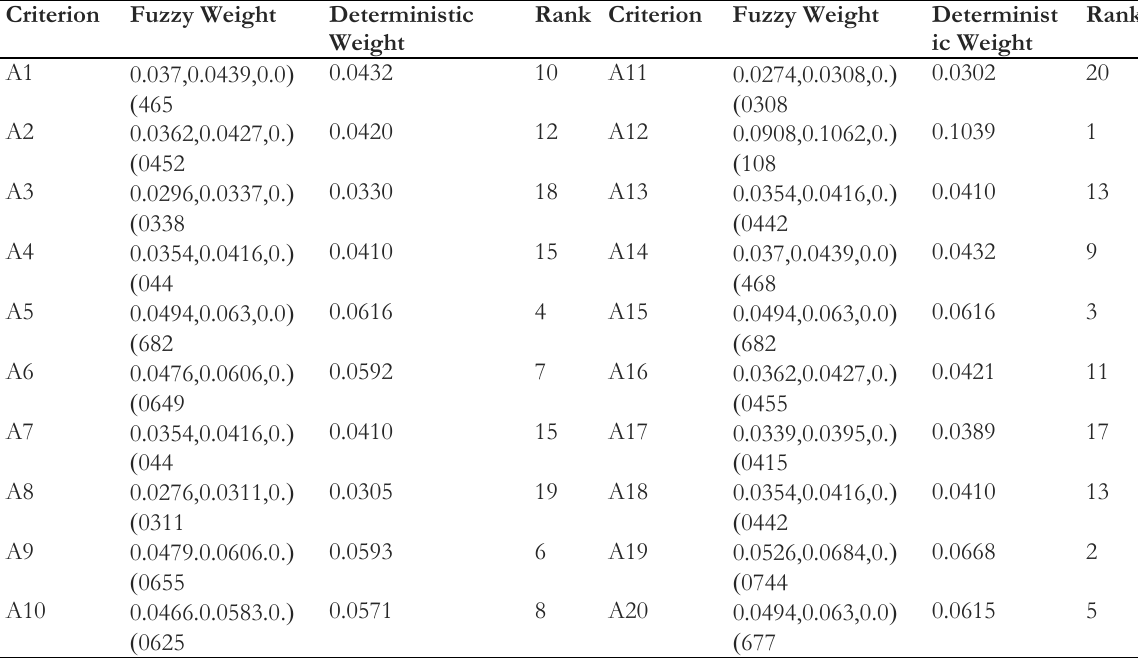
Table 7. Weights and the final ranking of legal challenges.